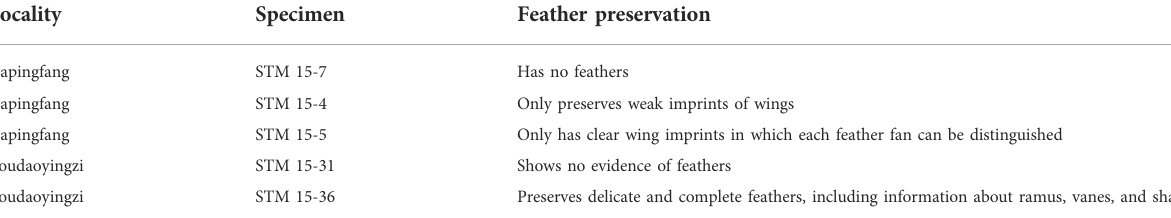
TABLE 1 Feather preservations of the fi ve Sapeornis specimens in this study.